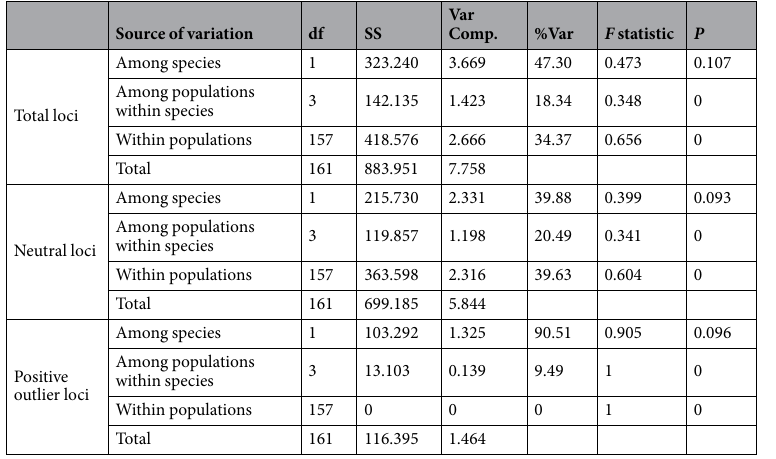
Table 2. Summary table for the analysis of molecular variance Results Genetic variation and population structure. According to the genetic assessment of 19 microsatellite loci, S . playfairii and S . tashiroi showed similar genetic diversity with respect to expected heterozygosity (ranges: 0.231 ± 0.061~0.340 ± 0.067 in S . playfairii and 0.253 ± 0.069~0.371 ± 0.069 in S . tashiroi ) and the inbreeding coefficient (fixation index: 0.431 ± 0.085~0.727 ± 0.053 in S . playfairii and 0.387 ± 0.061~0.663 ± 0.043 in S . tashi- roi ) (Table 1). The moderate heterozygosity levels and inbreeding coefficients suggest self-compatibility in both species, consistent with the inference of a selfing or sibling-mating tendency in small and isolated populations of S . montana 25 and S . indica 26 . The BayeScan approach found three positive outlier loci and one negative outlier